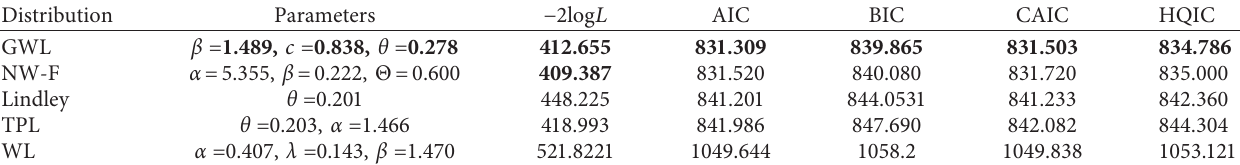
Table 5: Analysis results of remission dataset by Lee and Wang [15].